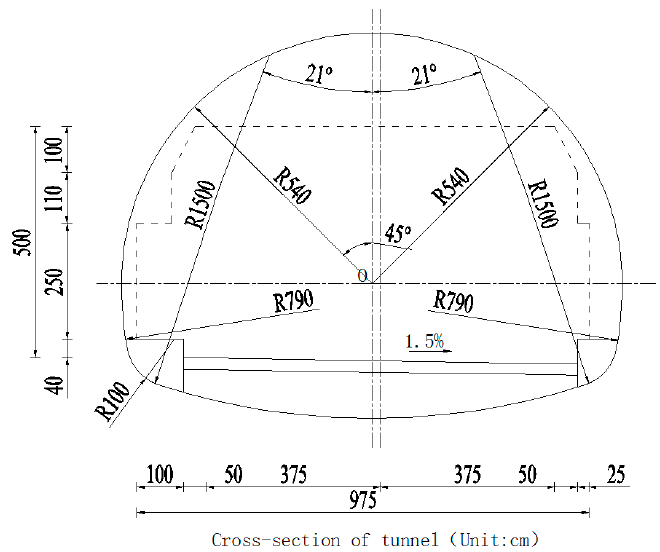
Figure 1. Cross-section of Qiaodaoliang Tunnel.